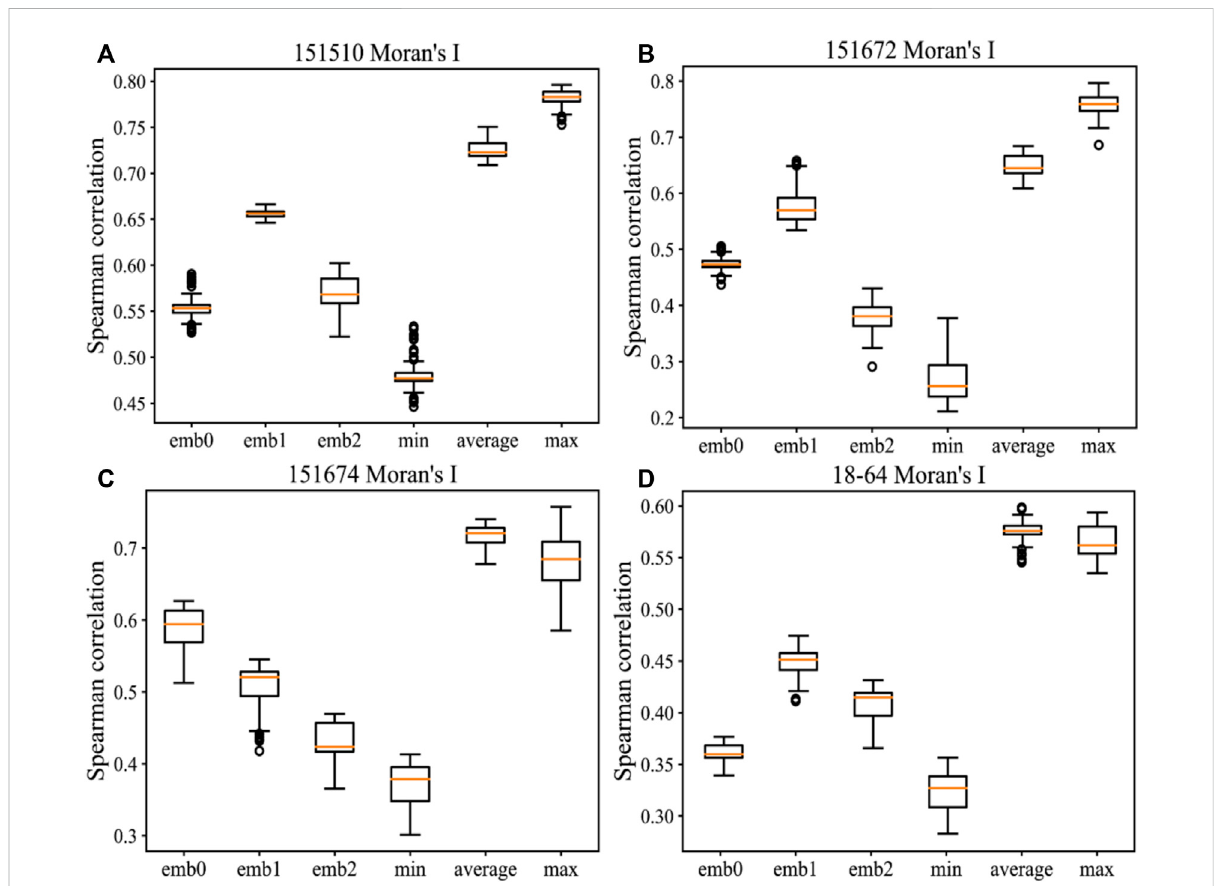
FIGURE 5 Comparison of different methods for measuring Moran ’ s I on the following samples: (A) 151510, (B) 151672, (C) 151674, and (D) 18 – 64. The horizontal axis shows the methods of directly measuring Moran ’ s I on the fi rst dimension (emb0), second dimension (emb1), and third dimension (emb2) in each embedding and the methods of combining Moran ’ s I with the minimum, average, and maximum fi ltering in all dimensions. The vertical axis shows the Spearman correlation measured by the ground-truth ranking and the ranking by MP-MIM. Each box shows all results in message passing with k_num values from 10 to 90 and l_num values from 1 to